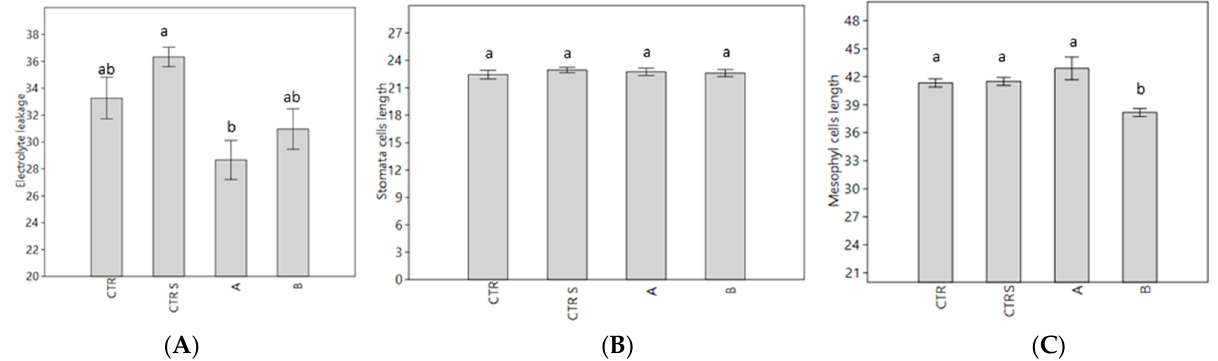
Figure 5. Electrolyte leakage expressed as µS/cm ( A ), stomata cell length in µm ( B ), and mesophyll cells in µm, ( C ). On the x-axis, CTR, CTRS, A: Phylgreen, B: Delfan Plus. Means followed by the same letter are not significantly different (Tukey test, p < 0.05). Data are means of three biological replicates ( n = 50). Bars represent standard error.